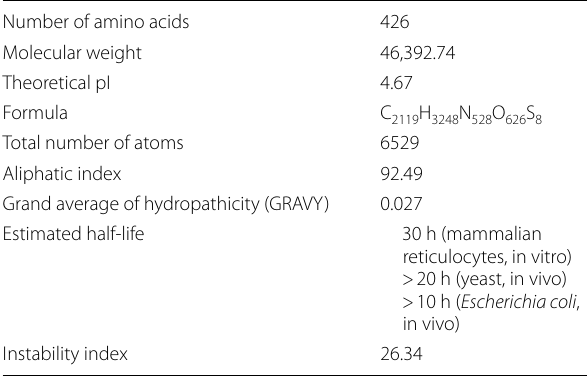
Table 6 Physiochemical properties identification of our vaccine